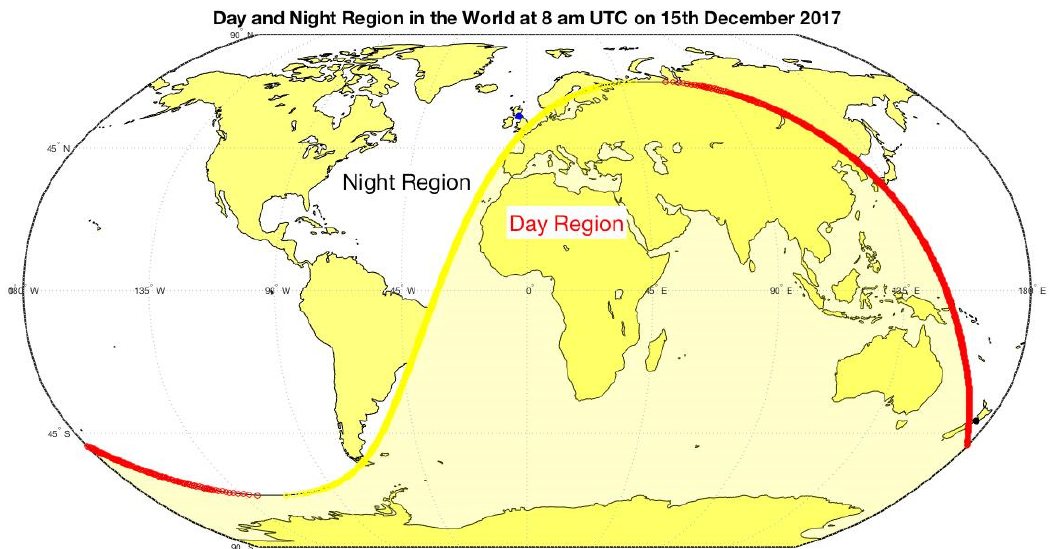
Figure 1. Day and night region for an example from 08:00 UTC on 15th December 2017 with the sunrise terminator in yellow and the sunset terminator in red. The shaded region is the day region. The blue triangle indicates the location of the United Kingdom, and the black triangle indicates the location of New Zealand.